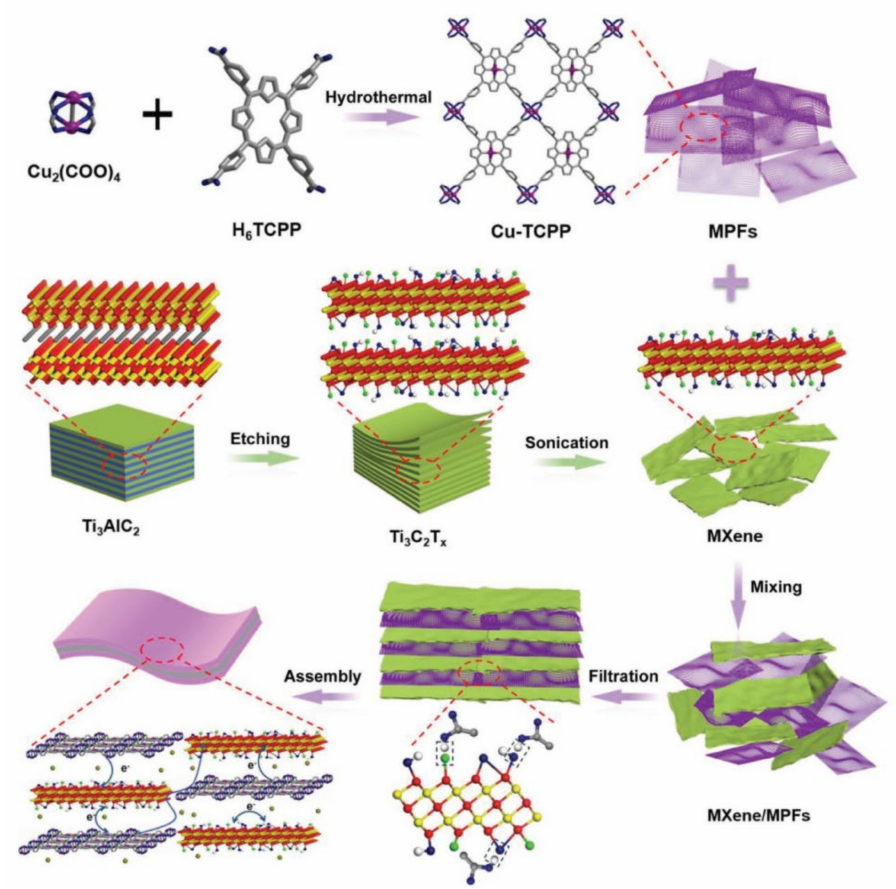
Figure 5. Schematic illustration of the synthesis process for the MXene/MPFs film via interlayer hydrogen bond